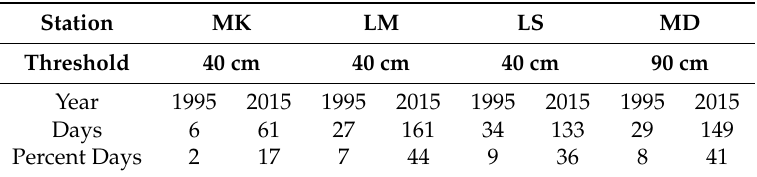
Table 6. Number of days per year of water level exceedance in 1995 and